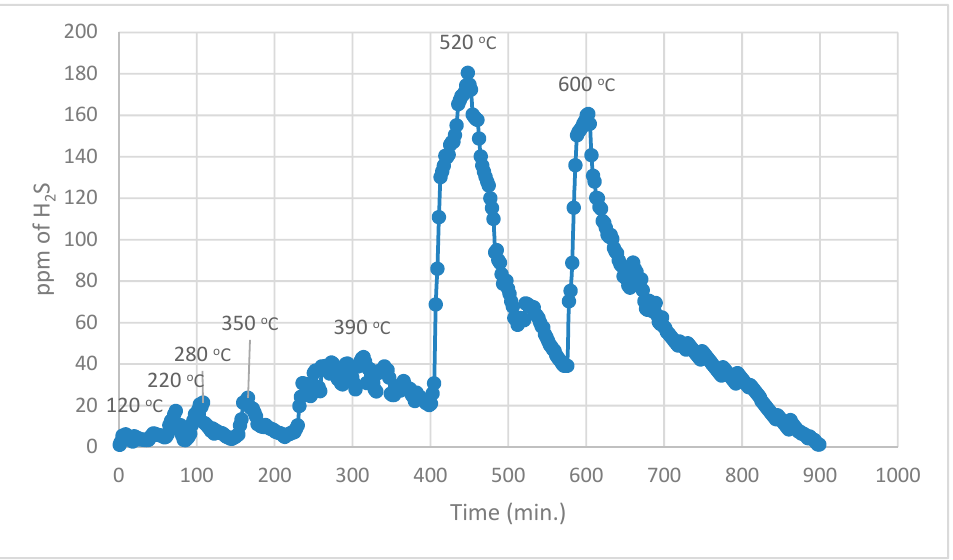
Figure 2. TPR of untreated harworth coal.